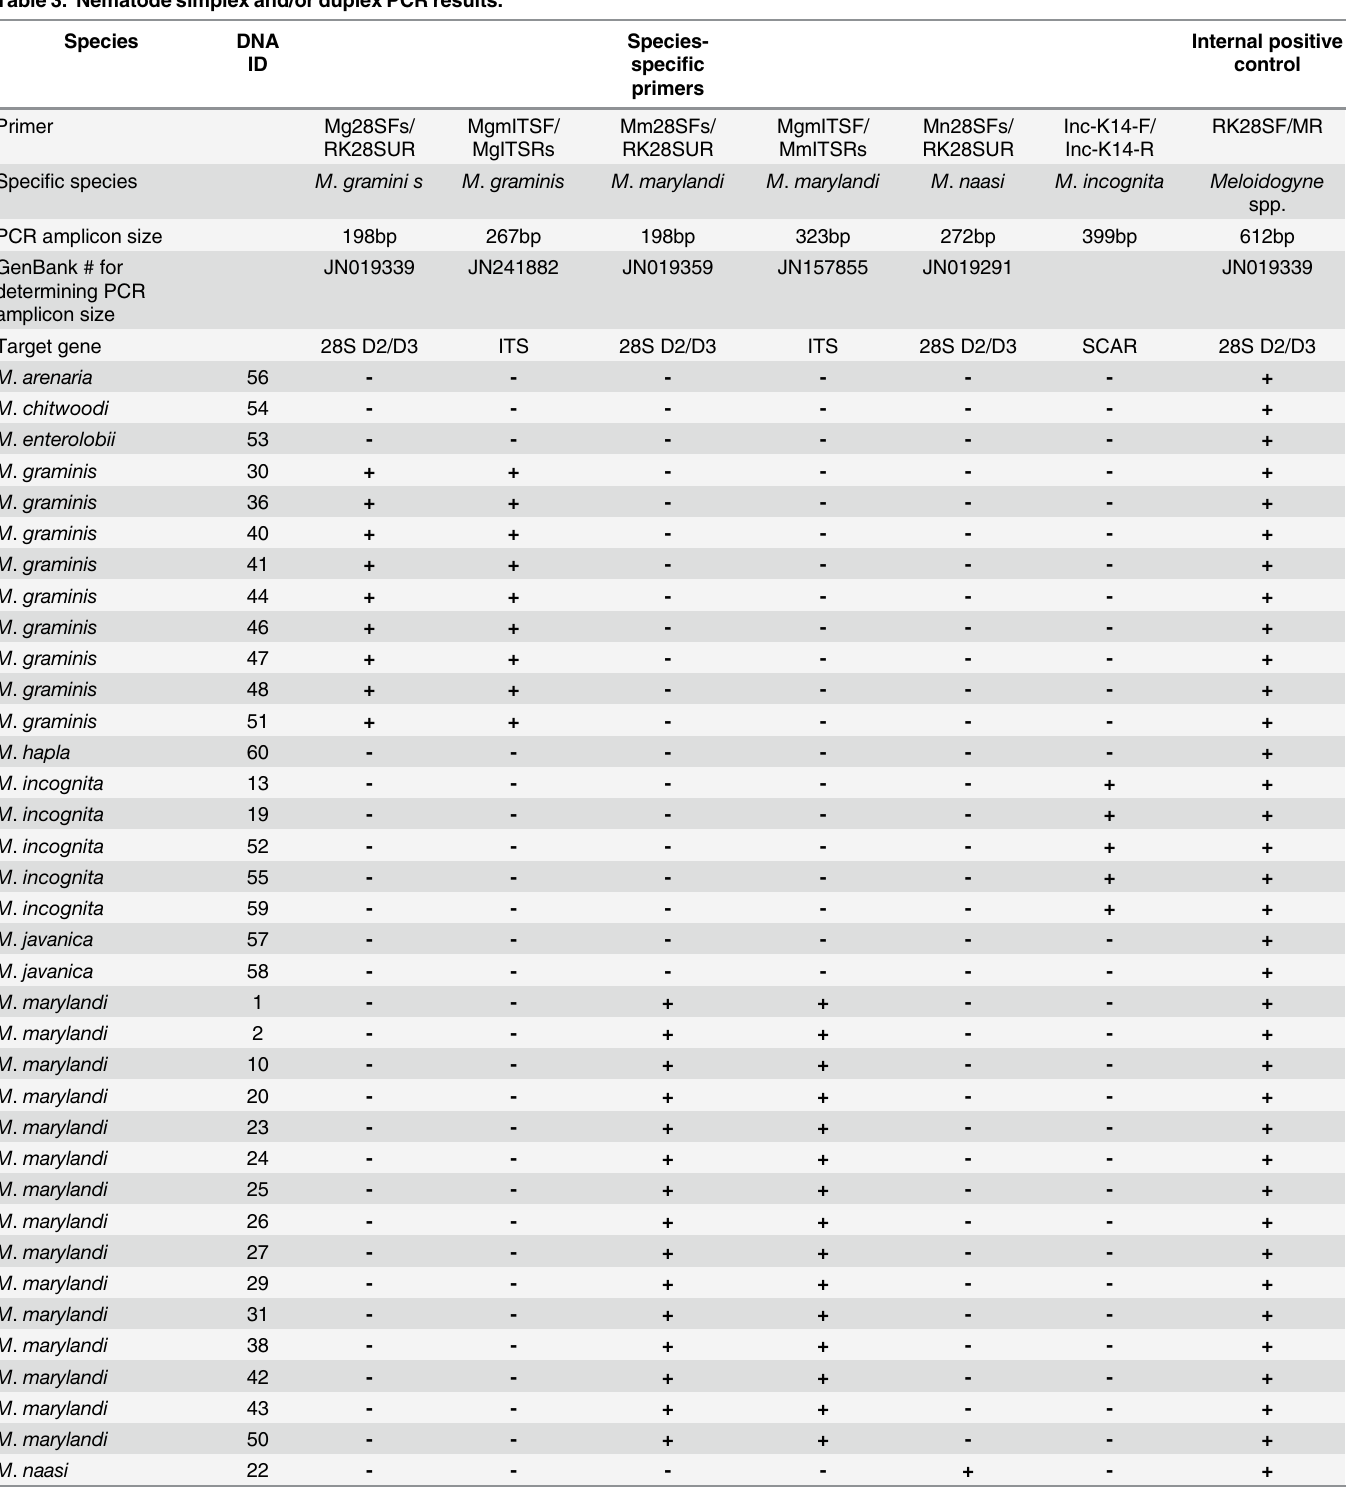
Table 3. Nematode simplex and/or duplex PCR